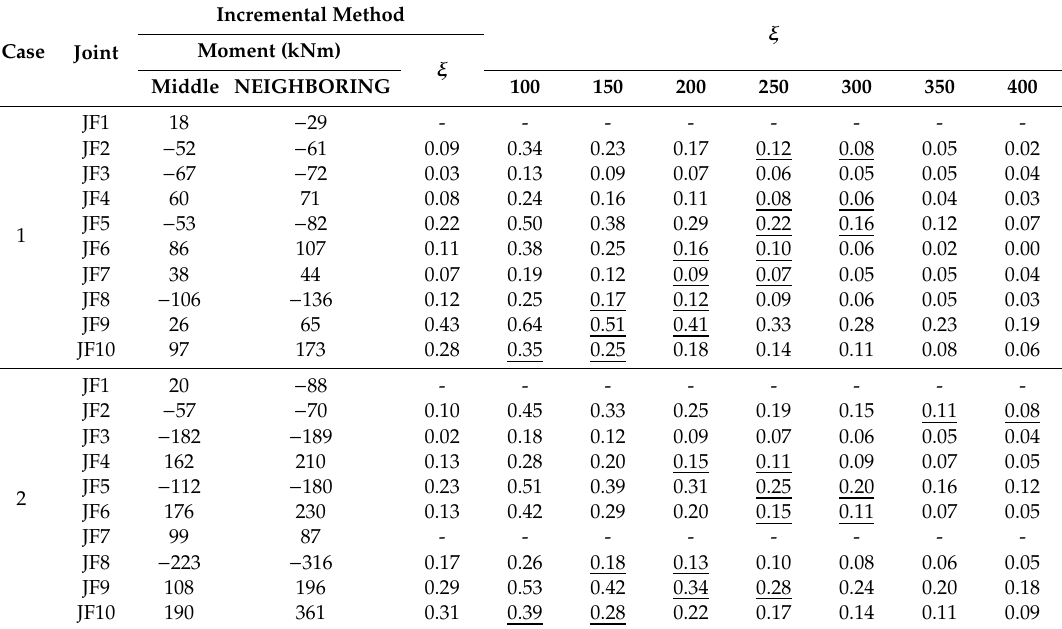
Table 6. Summary of the coe ffi cients of bending moment